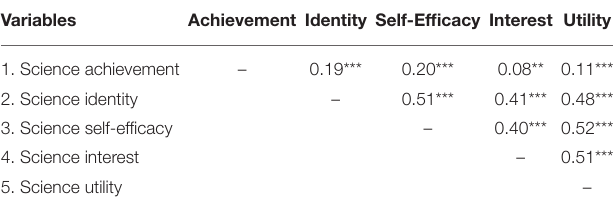
TABLE 2 | Correlation coefficients for the path analysis model variables ( N =